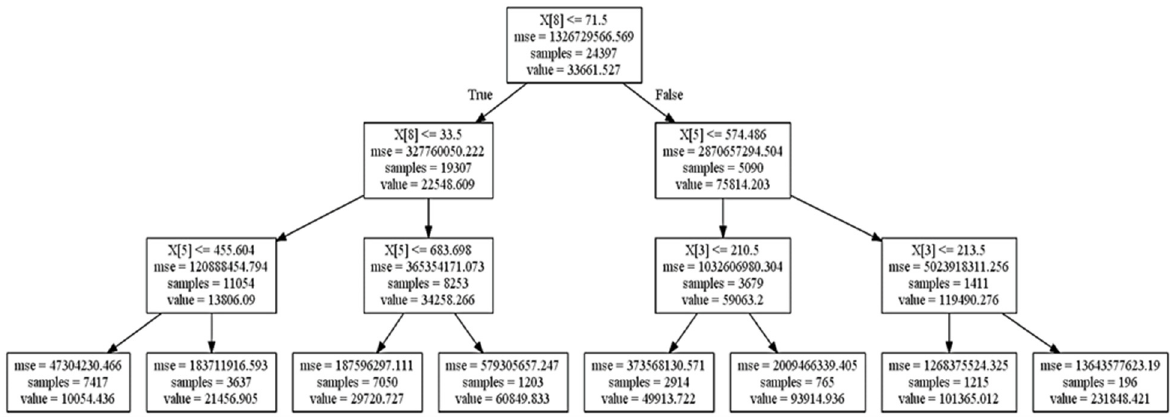
Figure 7. Decision tree regressor with depth set as 3.